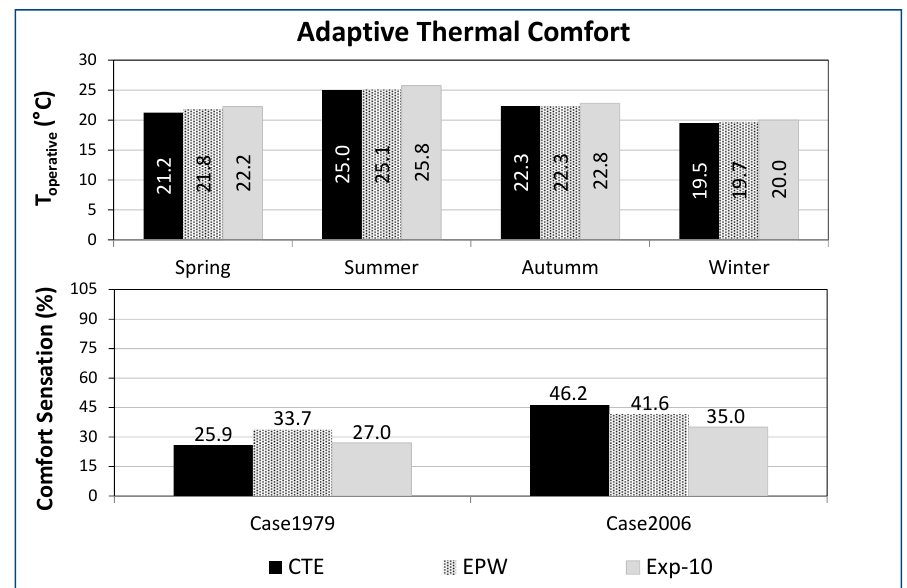
Figure 10. Thermal comfort sensation based on an adaptive model using the three climate databases of Madrid: CTE, EPW and Exp-10, and for the two building models, Case 1979 and Case 2006.